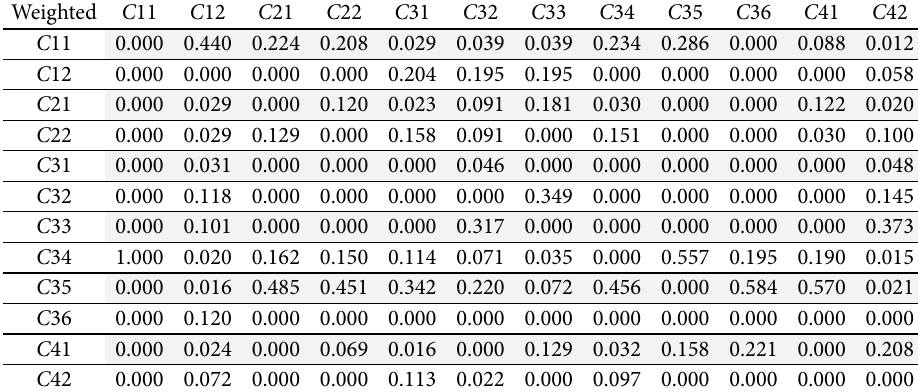
Table 8. Weighting the unweighted super-matrix based on total-influence normalized matrix